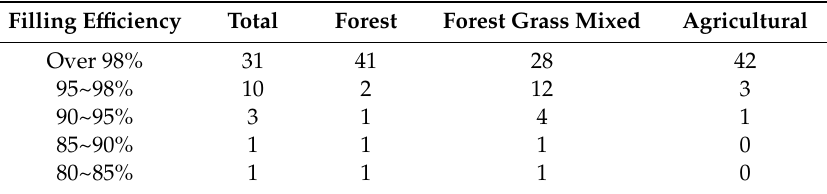
Table 3. Filling e ffi ciency of di ff erent land cover types.